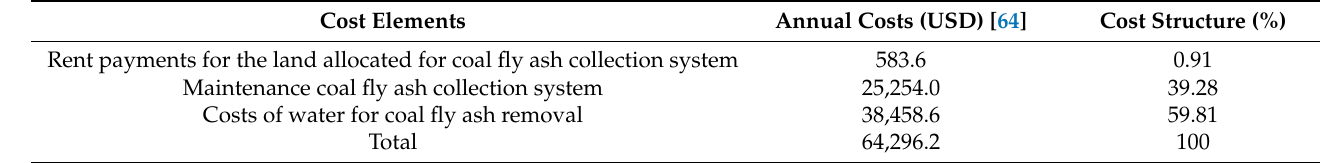
Table 4. Operational costs of CFA disposal and infrastructure maintenance. Source: designed by authors using [64,65]. Cost